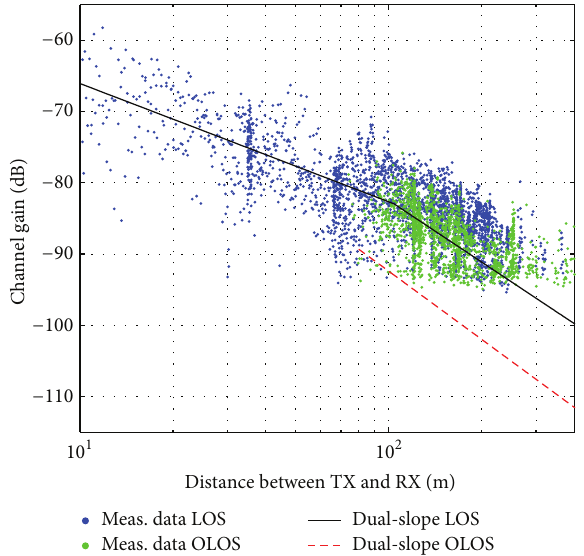
Figure 5: Measured channel gain for the highway environment and the least square best fit to the deterministic part of (4).